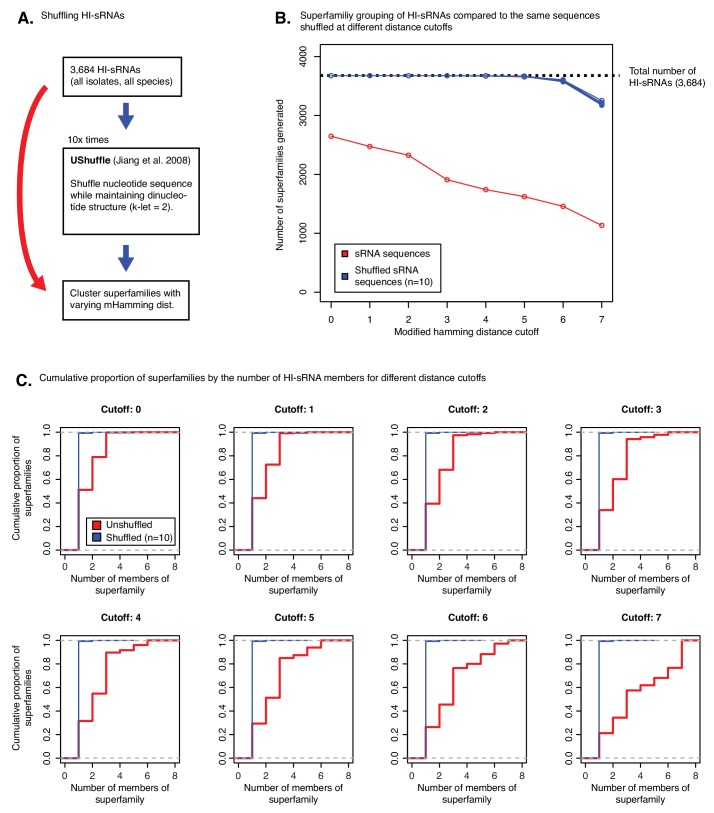
Testing distance cutoff parameters for superfamily formation.(A) Experimental pipeline for testing cutoff. sRNA libraries are shuffled using UShuffle maintaining dinucleotide composition. (B) Number of superfamilies formed for real HI-sRNAs and shuffled libraries by maximum distance allowed for cluster formation. Smaller count of superfamilies means that more HI-sRNAs are successfully clustering with each other. (C) The same analysis as in B, except demonstrating the cumulative density of superfamilies by the number of sRNAs grouped in them. Larger cutoffs yield larger superfamilies, with shuffled libraries remaining unable to form clusters larger than one or two.